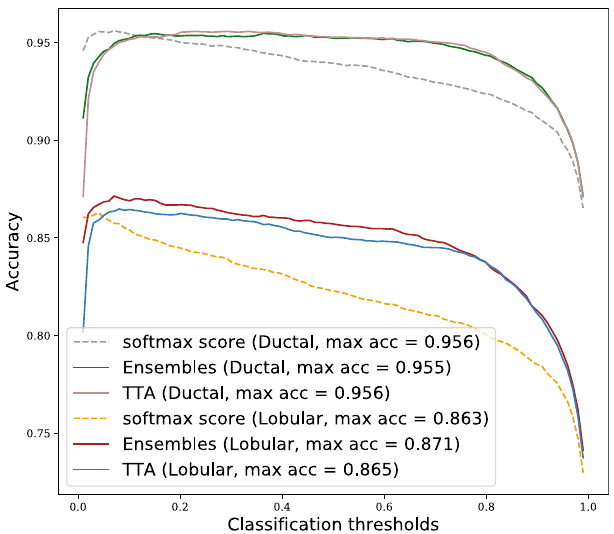
Figure 7. Prediction accuracy on Lobular and Ductal data when combining softmax tumour score from a single NN with sample means uncertainty estimated by ensembles and TTA methods.